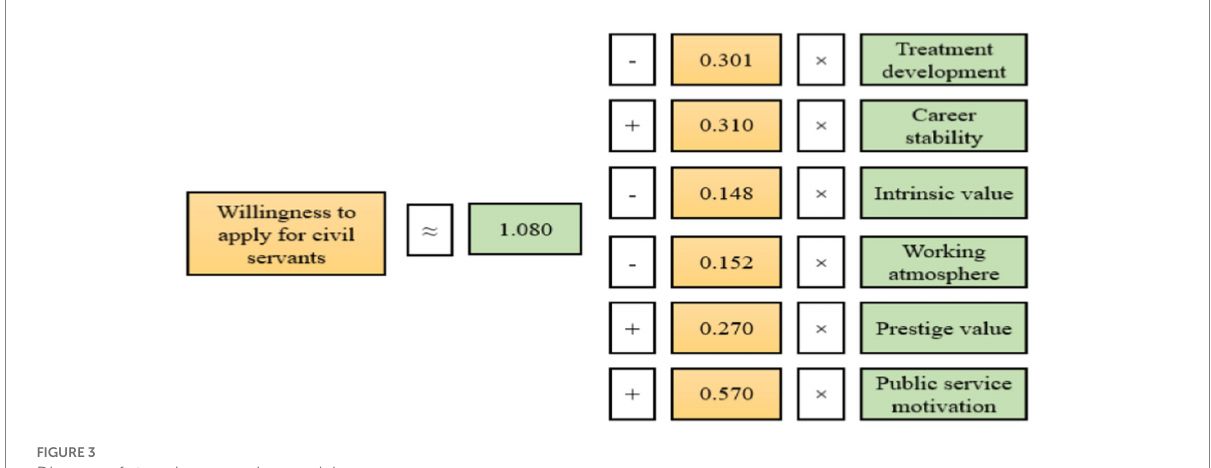
FIGURE 3 Diagram of stepwise regression model.